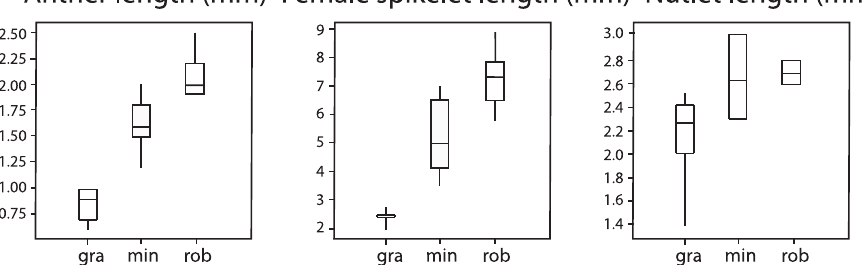
Figure 6. Box plots illustrating patterns of morphological variation among the species of Empodisma . The box spans the interquartile range of the values in the variate. The middle 50% of the data lie within the box, with a line showing the median. The whiskers extend beyond the ends of the box as far as the minimum and maximum